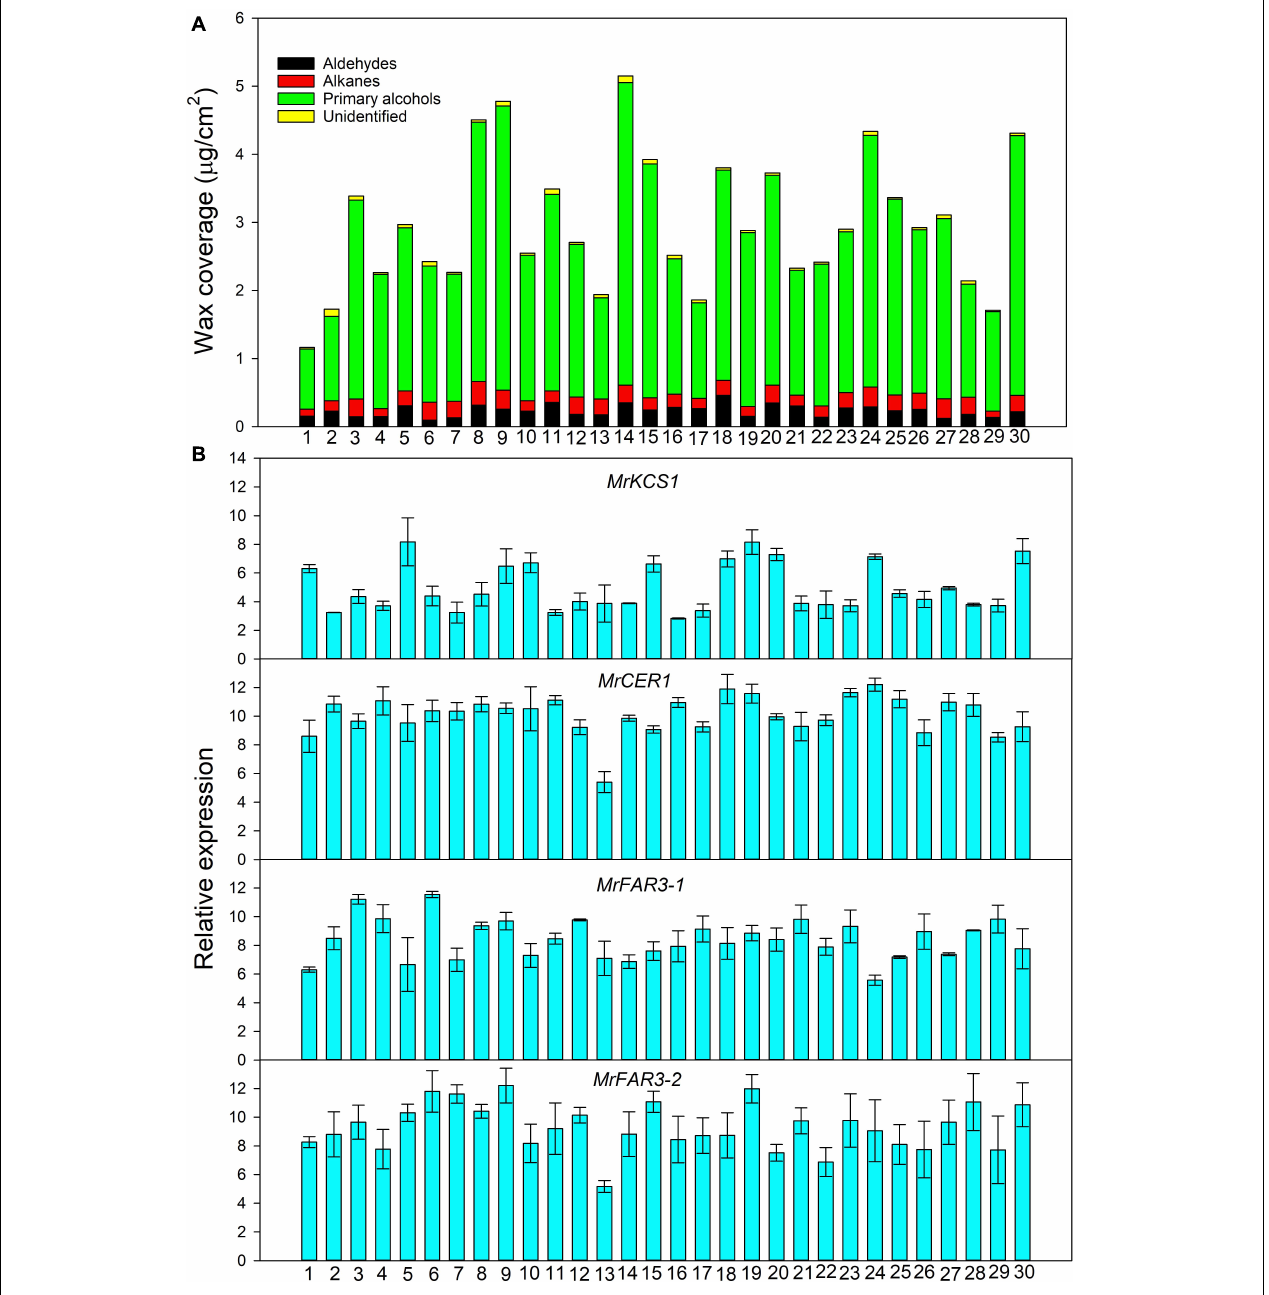
FIGURE 2 | Wax coverage (A) and expression of genes involved in wax biosynthesis (B) from 30 Medicago ruthenica